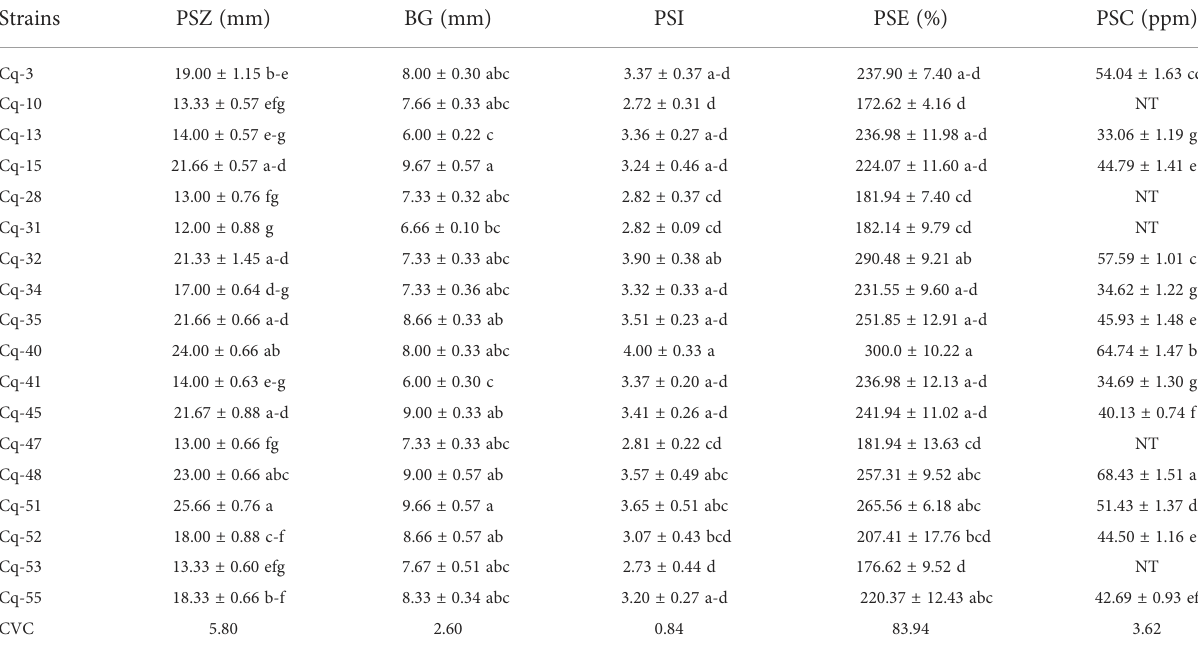
TABLE 1 Phosphate solubilization by rhizobacterial strains isolated from quinoa